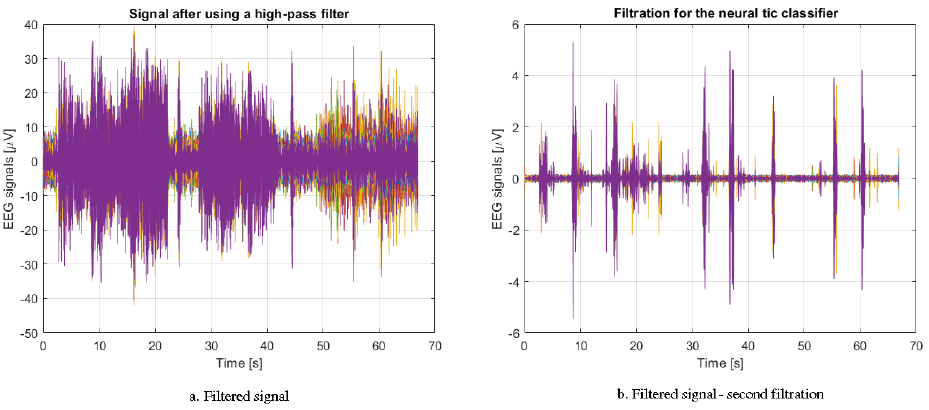
Figure 10. The observation of first-filtered and second-filtered EEG